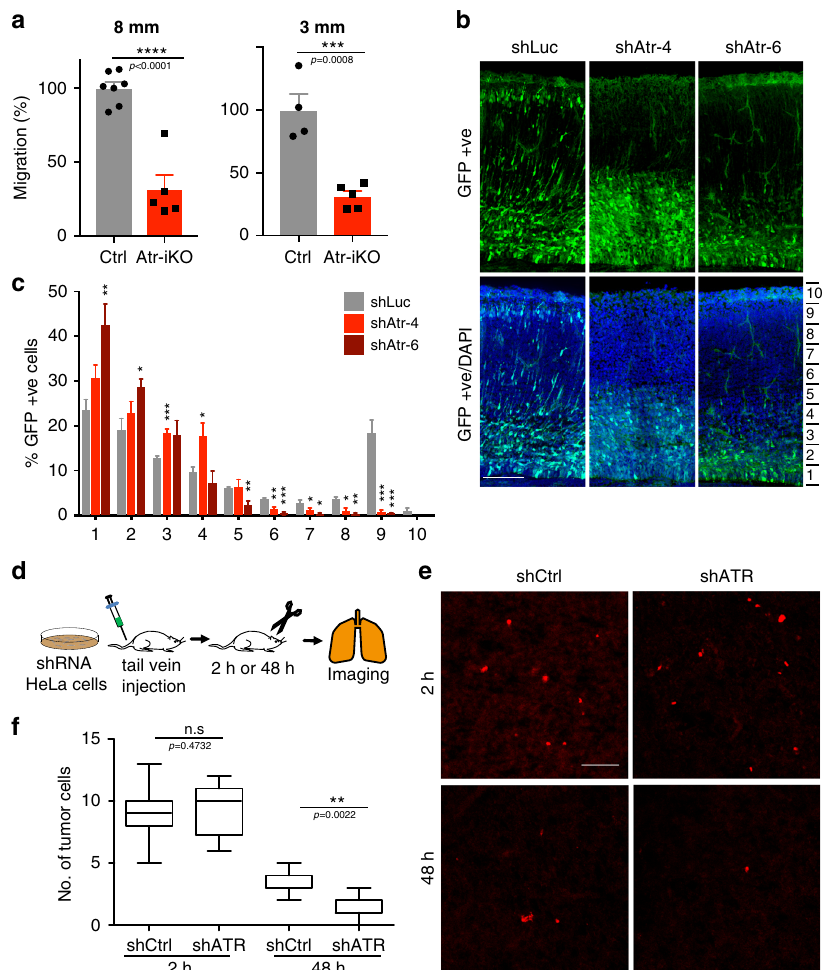
Fig. 5 Loss of ATR dampens neuronal migration and tumor cell circulation. a Relative migration of neuroprogenitors isolated from Atr-iKO mice brain were plated into 8 μ m ( n = 7, 5 cell lines) or 3 μ m ( n = 4, 5 cell lines) polycarbonate membrane insert (ThinCert ™ ), allowed to migrate for 20 h, then fi xed and counted (neuroprogenitors isolated from 13 embryos from 2 pregnant mice independently). b , c In vivo neuronal migration: b images of